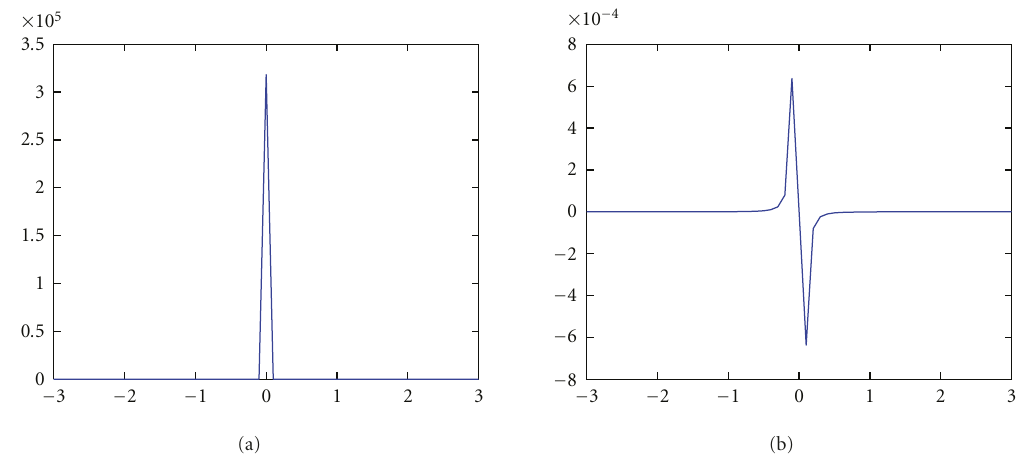
Figure 4: (a) δ ( x ) = ( ε/π ) / ( x 2 + ε 2 ), ε = 10 − 6 and (b) δ (cid:2) ( x ) = − 2 εx/π ( x 2 + ε 2 ) 2 , ε = 10 − 6